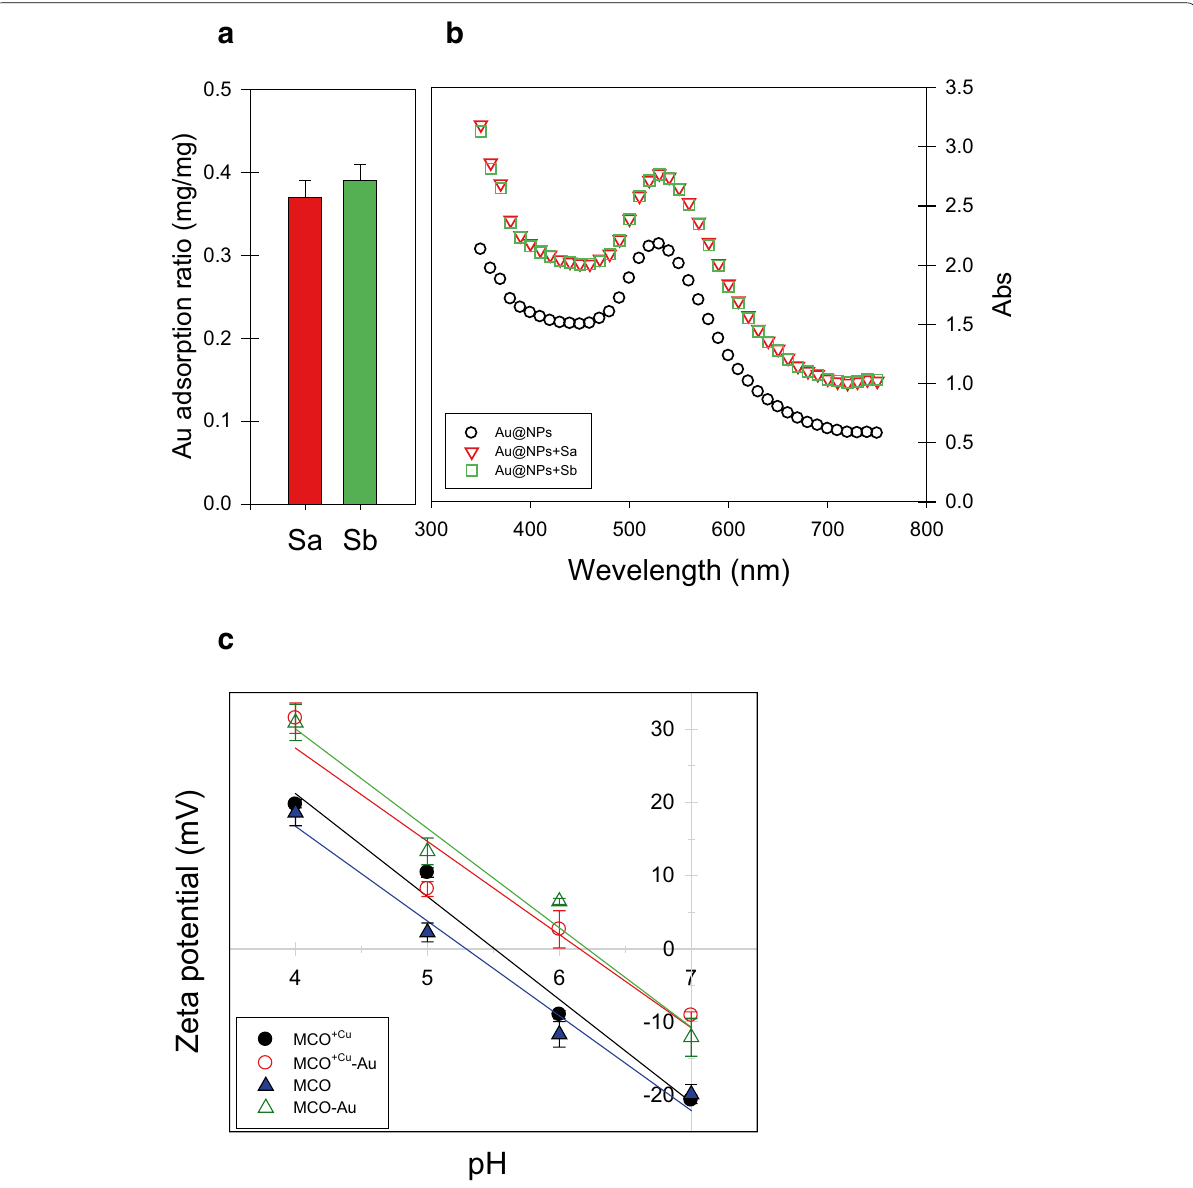
Fig. 5 Application of recombinant LacB in Au adsorption. a Supernatant fractions of MCO produced by BL21 cells harboring the pET28a‑lacB vector under IPTG and copper (Sa), or IPTG only (Sb). b Spectrum scanning of free Au@NPs or Au@NPs adsorption by Sa and Sb. c Zeta potential analysis of MCO and MCO + Cu before and after adsorption of